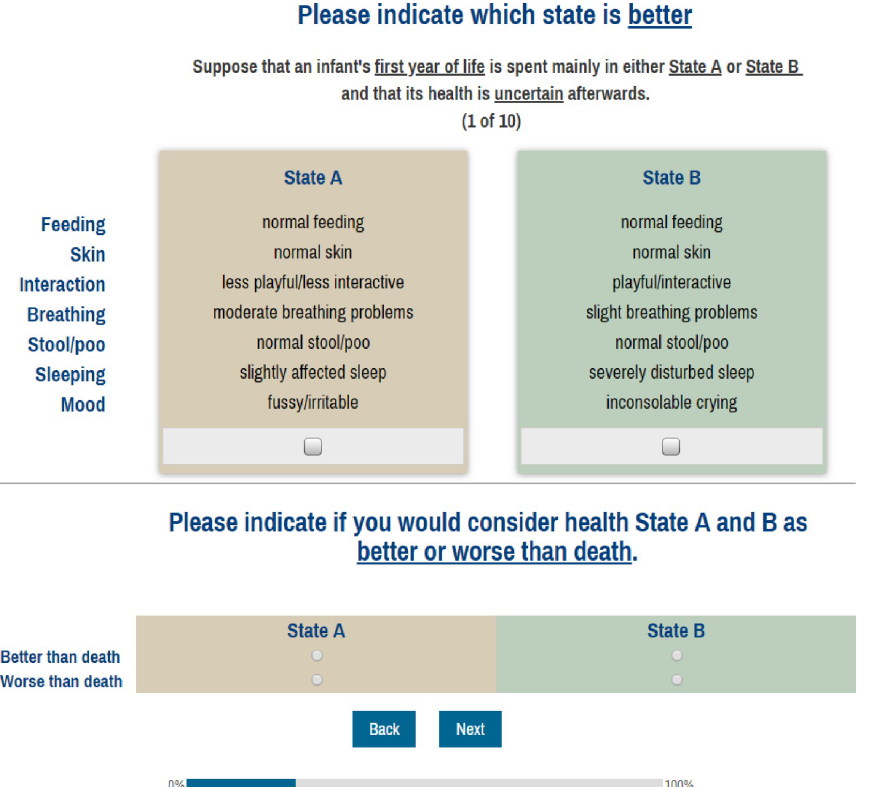
Fig 2. Screenshot of the discrete choice task and the complementary “better or worse than death”